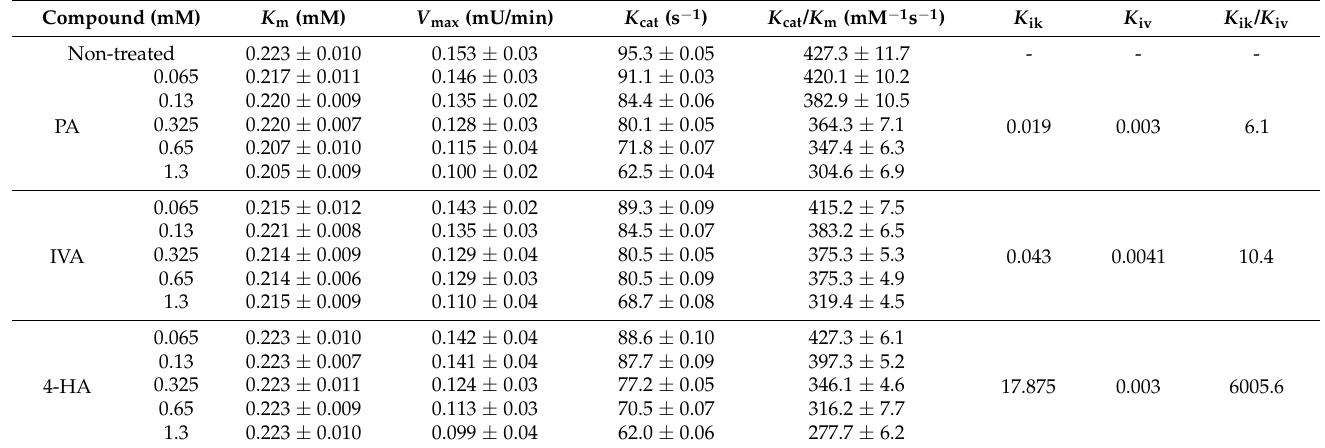
Table 3. Effect of PA, IVA, and 4-HA on kinetic parameters of